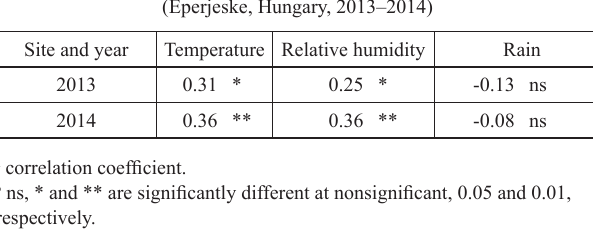
Table 2. Correlation coefficients ( r ) between mean hourly concentration of Monilinia spp conidia and temperature, relative humidity and rain